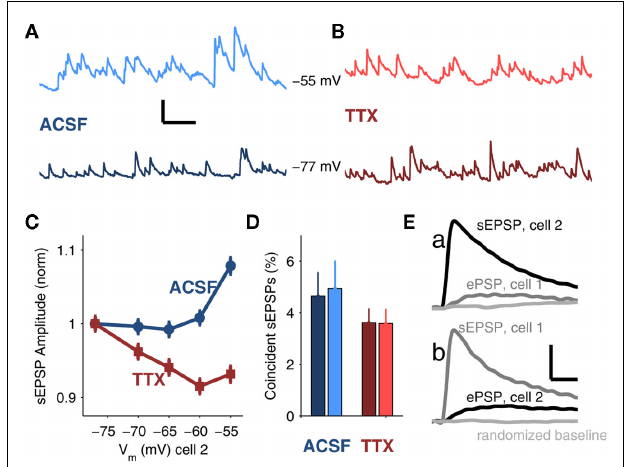
FIGURE 4 | Spontaneous excitatory postsynaptic events (sEPSPs) in coupled neurons. (A) Sample data from aTRN cell with average V m =− 55mV (top, light blue) and − 77 (bottom, dark blue) in ACSF. Scale bar is 0.1s, 1mV. (B) Sample data with average V m =− 55mV (top, light red) and − 77 (bottom, dark red) in 100nMTTX. (C) Average sEPSP amplitude (mean ± SEM) plotted against V m for recordings in ACSF (blue, circles) and recordings inTTX (red, squares). Both data sets are normalized to their respective values at V m =− 77mV for comparison (normalized values at V m =− 55mV are 1.08 ± 0.01 in ACSF; 0.93 ± 0.01 inTTX). (D) Percentages of sEPSPs arriving in both cells of a coupled pair within a 1ms window in ACSF (4.6 ± 0.93 for V m =− 77mV, dark blue; 4.9 ± 1.1 for V m =− 55mV, light blue) and inTTX (3.6 ± 0.54 for V m =− 77mV, dark red; 3.6 ± 0.54 for V m =− 55mV, light red).There were no significant effects of voltage orTTX on the data (ANOVA). (E) In a strongly coupled pair (mean cc = 0.4), average sEPSP in cell 2 ( a , black trace) and corresponding trigger-averaged electrical PSP (ePSP) simultaneously recorded in cell 1 ( a , gray trace); average sEPSP in cell 1 ( b , gray grace) with corresponding average ePSP simultaneously recorded in cell 2 ( b , black trace). Randomly selected data from the same number of samples are shown in light gray. All traces in (E) represent the average of 554 events. Scale bar is 0.1mV,